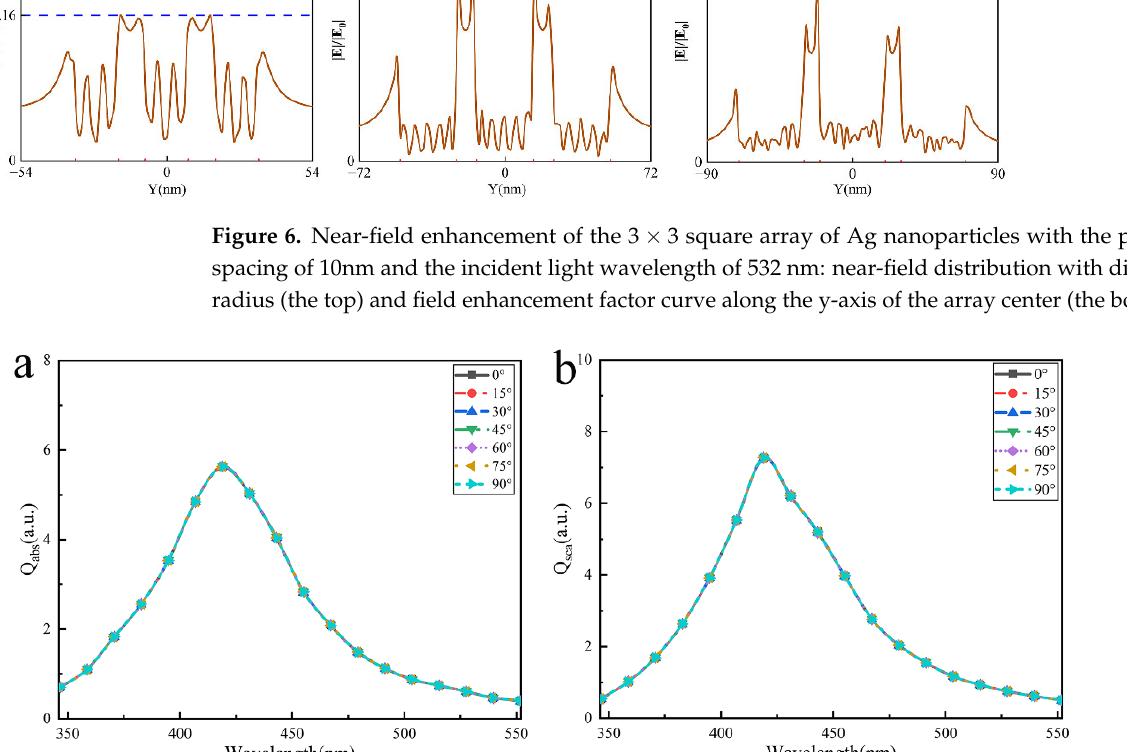
Figure 6. Near ‐ field enhancement of the  3 3 square array of Ag nanoparticles with the particle spacing of 10nm and the incident light wavelength of 532 nm: near ‐ field distribution with different radius (the top) and field enhancement factor curve along the y ‐ axis of the array center (the bottom).